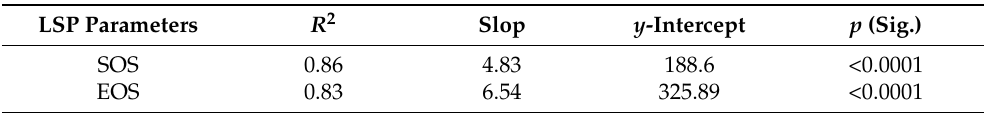
Figure 6. Latitudinal variation in the LSP parameters, SOS and EOS in the Middle East over the period of 2000–2020. The SOS and EOS dates were converted to days. For instance, July in year y − 1 would be around 210 days (7 × 30 ≅ 210). Table 2. The coefficient of determination ( R 2 ), slopes, and y-intercept of the linear regression between LSP parameters and latitude during.